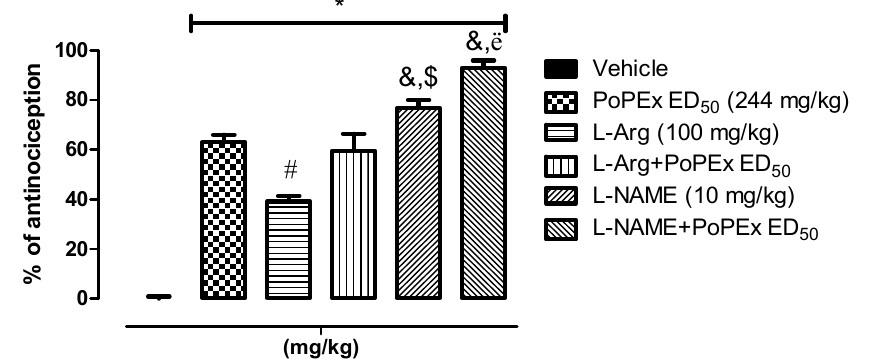
Figure 4. Involvement of the L -Arginine/NO/cGMP pathway. Overall effect of the doses of L -Arginine (100 mg/kg) and L -NAME (10 mg/kg) on the PoPEx ED 50 was evaluated. The rats were pretreated with an intraperitoneal injection of L -Arginine and L -NAME. * = statistically significant effect ( p < 0.05) of all groups versus vehicle. # = statistically significant effect ( p < 0.05) of L -Arginine versus PoPEx ED 50 . &,$ = statistically significant effect ( p < 0.05) of L -NAME versus PoPEx ED 50 and L -NAME + PoPEx ED 50 . ë = statistically significant effect ( p < 0.05) of L -NAME + PoPEx ED 50 versus L -NAME (determined by one-way ANOVA followed by the Bonferroni test). Each bar corresponds to the mean ± EE of six animals.